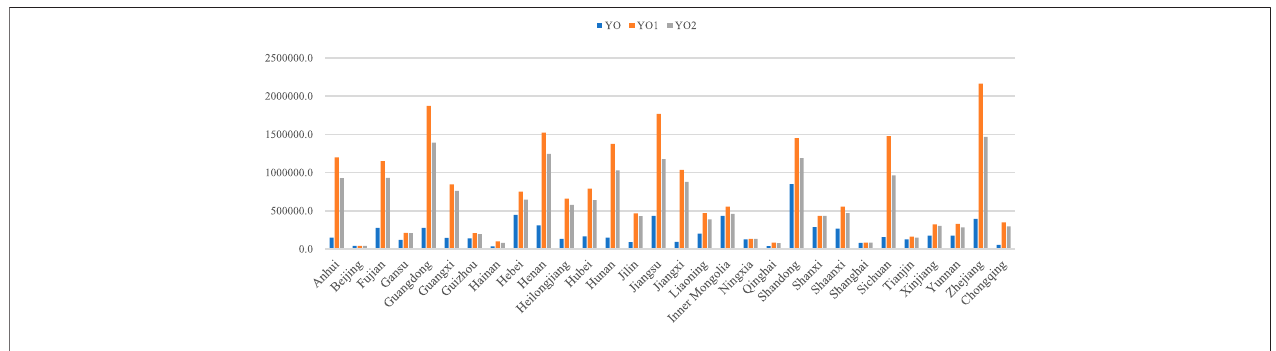
FIGURE 6 | Average projection comparison for YO in 30 provinces during 2011 –